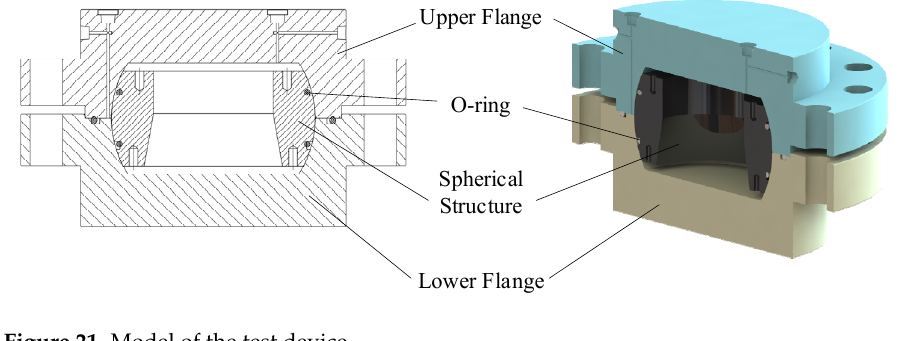
Figure 21. Model of the test device.